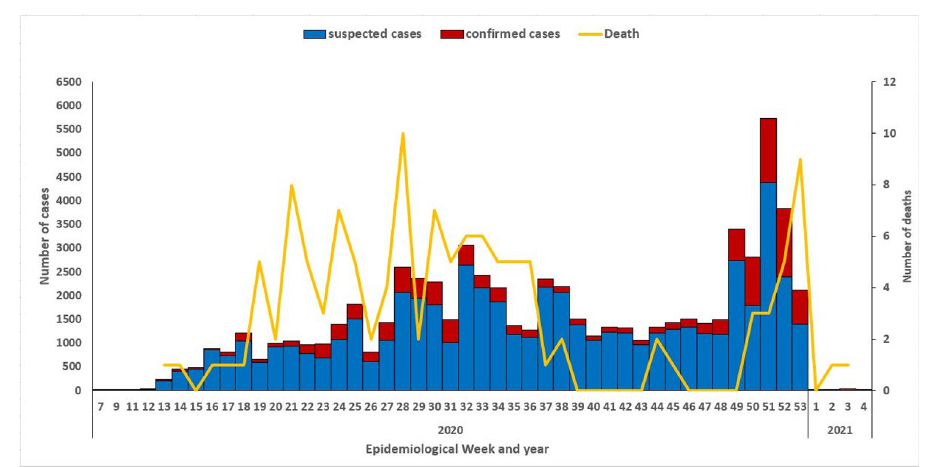
Fig 2. Distribution of suspected and confirmed COVID-19 cases in FCT from March 2020-January 2021.